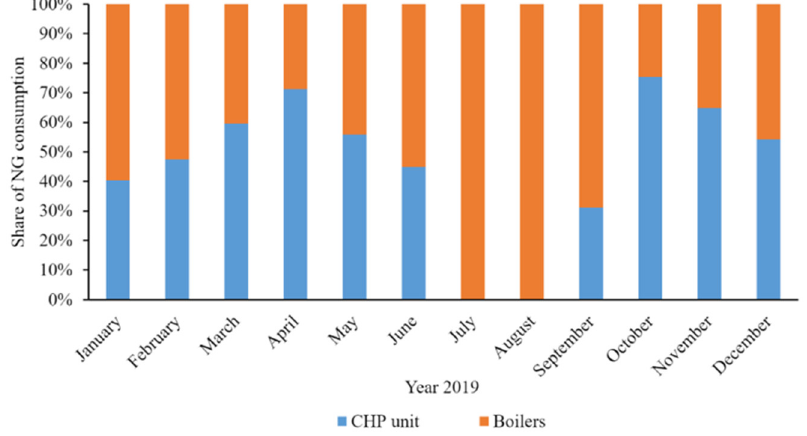
Figure 7. Share of the NG consumption by the CHP unit and boilers (year 2019). Table 5. Monthly operational data/performance parameters of the CHP unit (year 2019).